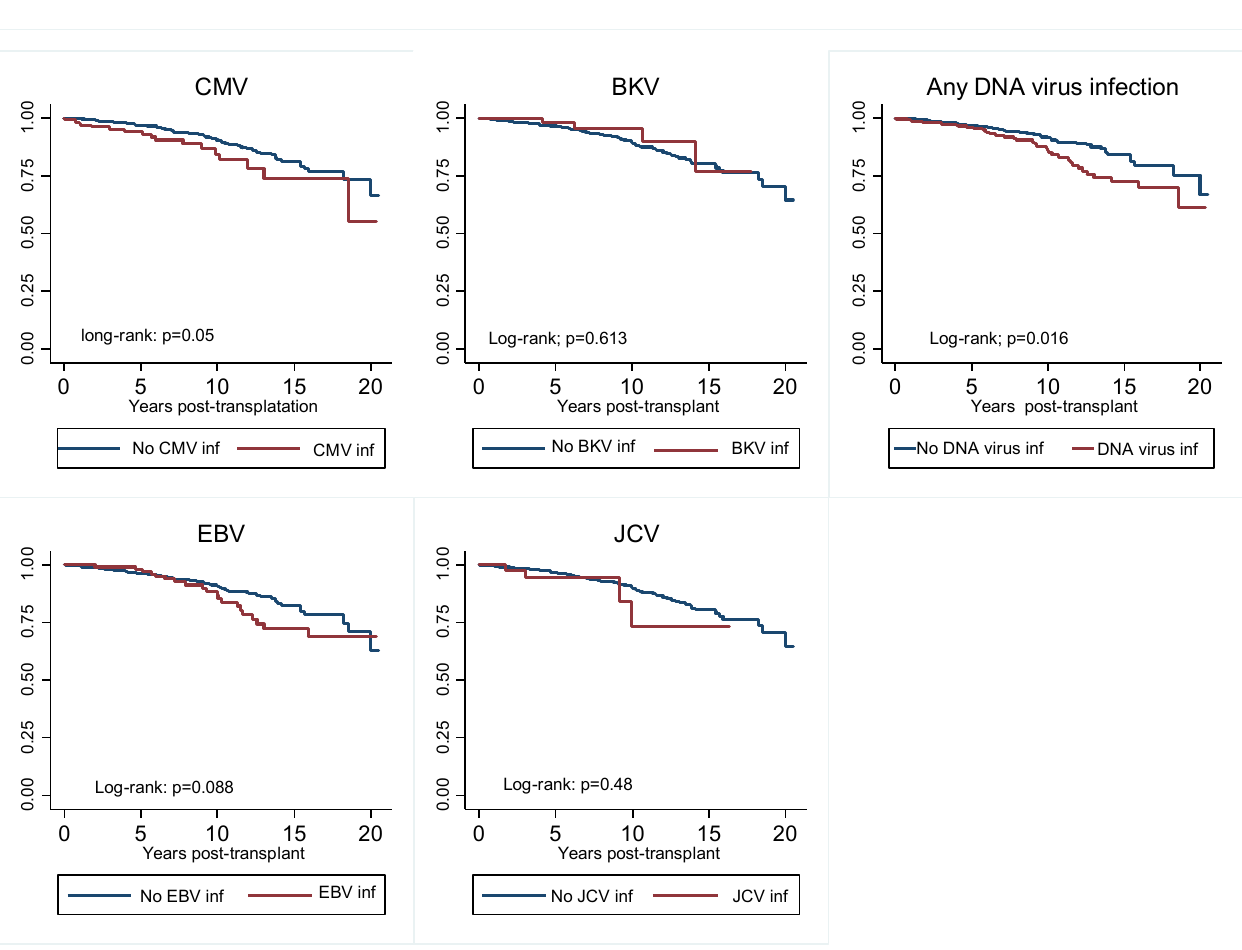
Figure 4. Kaplan–Meier curve showing graft survival censored for death of viremia group compared to non-viremia group for individual DNA virus infections, as well as those who experienced any viremia vs. those who did not. CMV, cytomegalovirus; EBV, Epstein Bar virus; JCV, John Cunning- ham.